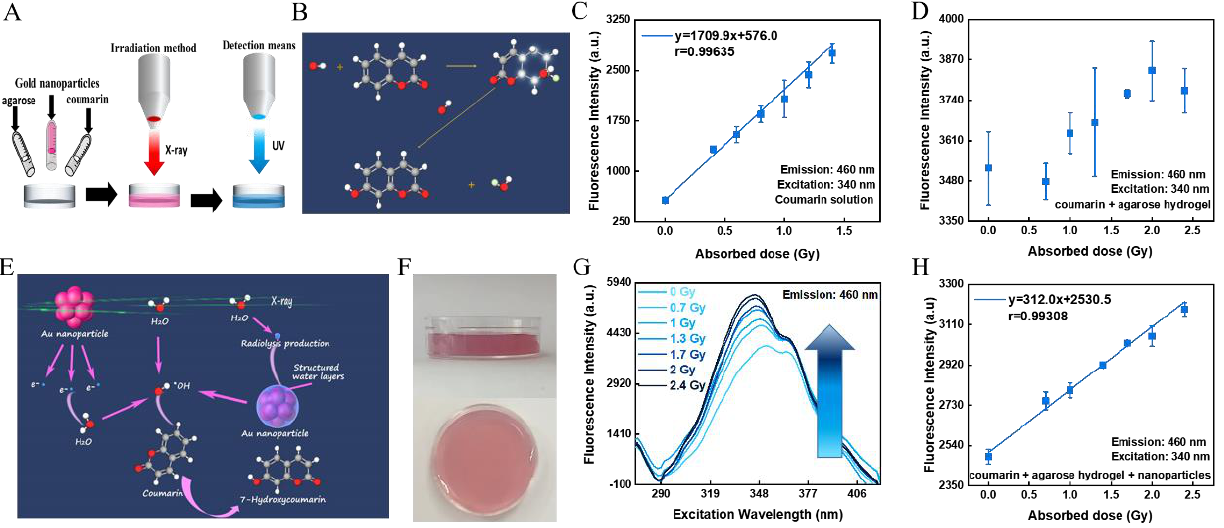
Figure 1. Dose-response and principles of hydrogel sensors. ( A ) Flow diagram of the preparation and irradiation process of a hydrogel sensor. ( B ) Schematic representation of the reaction of · OH with COU to form 7-HCOU. ( C ) Fluorescence intensity of COU solution (0.5 mM) being irradiated for different doses. ( D ) Fluorescence intensity of mixed gel of COU (0.5 mM) and agarose (3 wt%) being irradiated for different doses. ( E ) Schematic diagram of the pathway of · OH production and 7-HCOU in a hydrogel sensor containing GNPs. ( F ) Top and front view of the hydrogel sensor. ( G ) Fluorescence intensity with different excitation wavelengths of the hydrogel sensor containing GNPs. ( H ) Fluorescence intensity of agarose (3 wt%) hydrogel sensor containing GNPs (0.1 mM) and COU (0.5